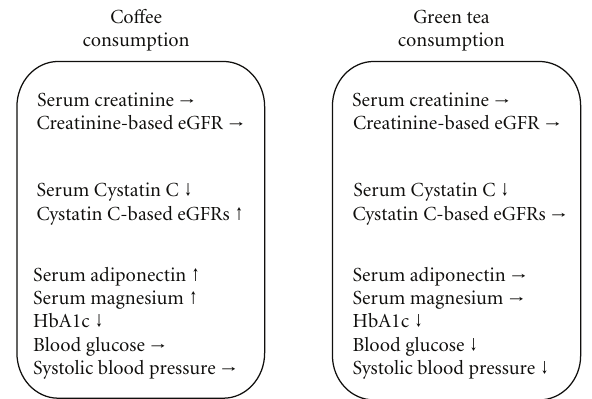
Figure 1: Summary of changes in variables according to co ff ee consumption and green tea